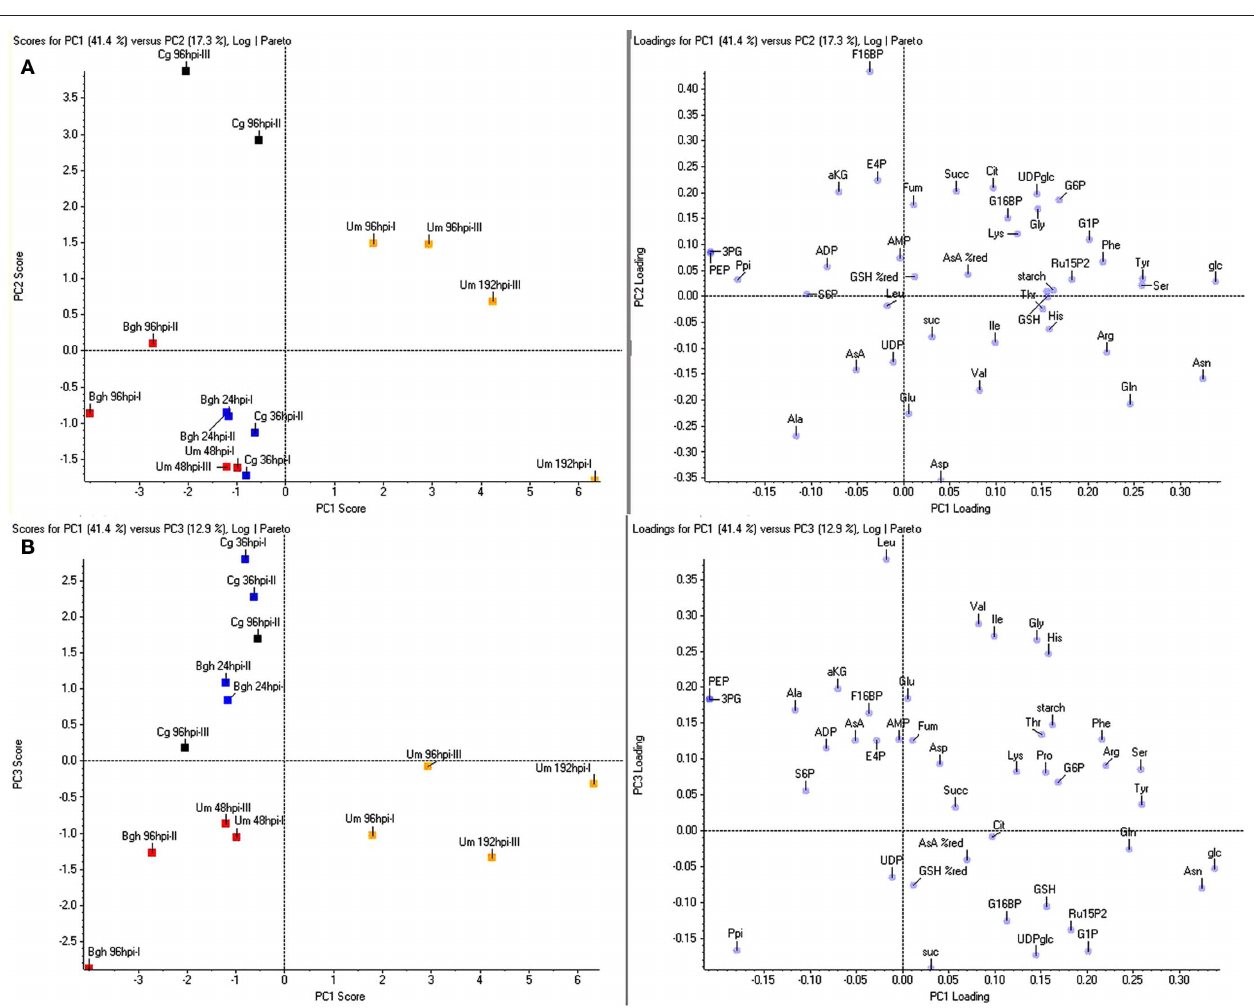
Figure 3 | Principle component analysis of metabolite data. For principle component analysis (PCA), the same metabolite ratios as in Figure 1 were used, representing the ratio infected/mock calculated from the mean values of four sample replicates each. Per pathosystem, data from two independent experiments (designated by Roman numbers) were employed for PCA. (A) PC1 vs. PC2. (B) PC1 vs. PC3. Bgh , Blumeria graminis f.sp. hordei ; Cg , Colletotrichum graminicola ; Um , Ustilago maydis ; yellow, tumor, red, established biotrophy, blue, early biotrophy, black, necrotrophy. Amino acids and nucleotides are abbreviated according to three letter code, aKG, ( α -ketoglutarate) AsA